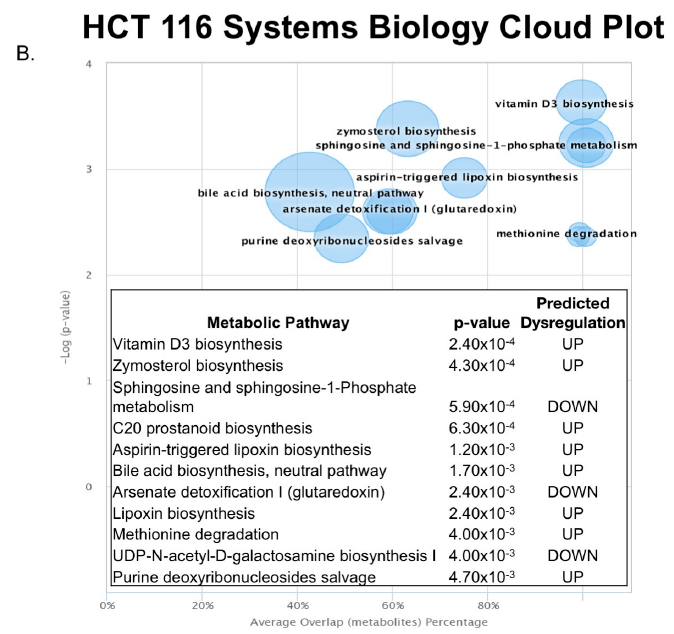
Figure 5. ( A ) XCMS online was used to compare metabolite differences between treated and untreated HCT 116 cells. A cloud plot was produced to compare features plotted on m / z (y-axis) and retention time (x-axis). XCMS identified 159 metabolites up or downregulated by treatment in HCT 116 cells, which are represented by green and red circles, respectively. Size and color of the circles correspond to the log fold change and p -value respectively; ( B ) Using the 159 differential metabolites, XCMS maps the metabolites to metabolic pathways represented on a cloud plot. Pathways with greater percent overlap of metabolites and statistical significance will appear in the upper right corner of the cloud plot. Eleven pathways were found to have a p -value < 0.01 and their predicted dysregulation is shown in the table.